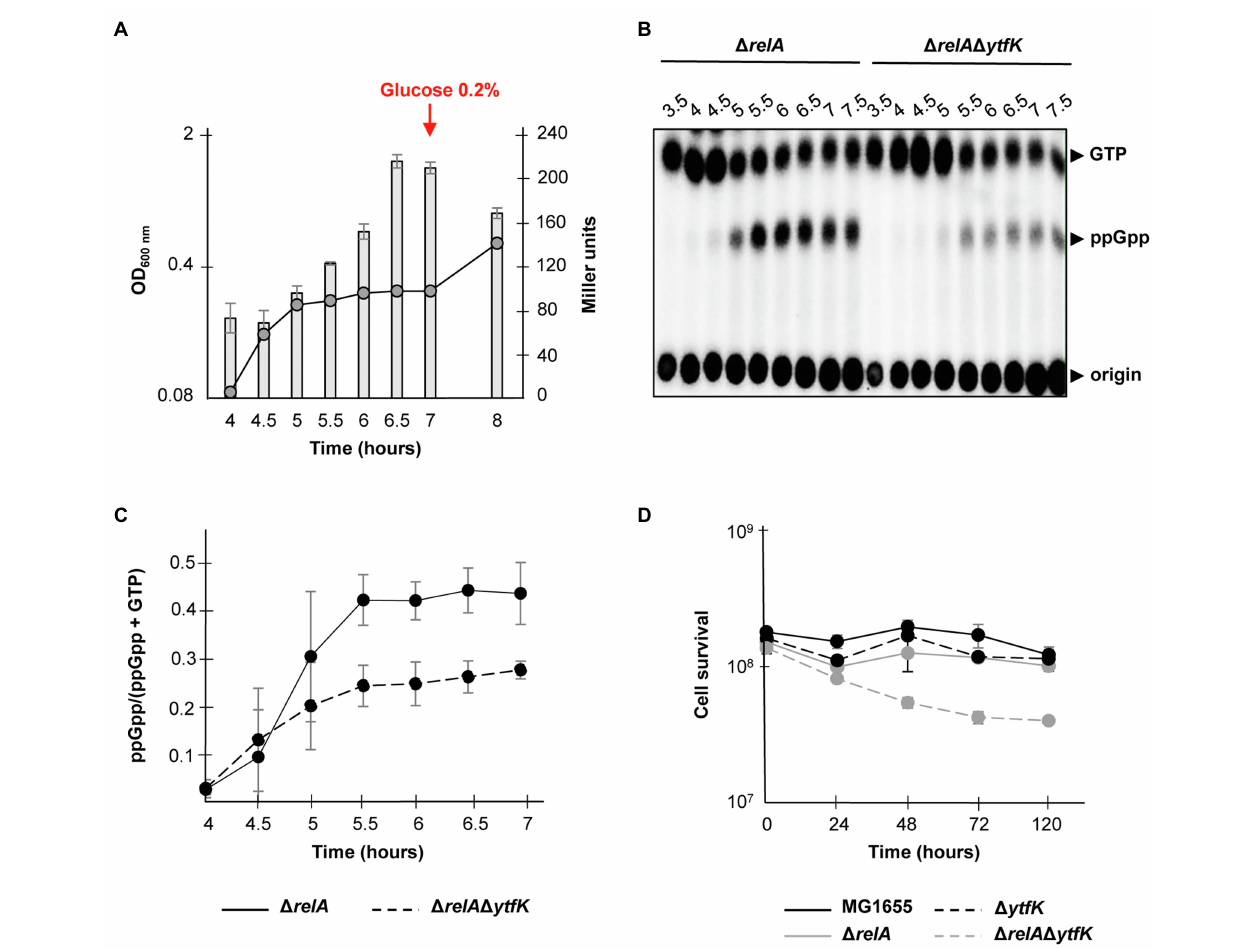
FIGURE 4 | ytfK is required for SpoT-dependent (p)ppGpp accumulation during glucose exhaustion. (A) Growth curve and β -galactosidase activity assay of WT cells in glucose limited minimal medium. WT (TB28) cells harboring the transcriptional fusion ( ytfK P1+ P2) were grown in MOPS minimum medium containing 0.025% glucose. The OD 600nm values of the cultures (curve) were taken and β -galactosidase activity (bar chart) was measured at indicated times. After 7 h of growth, glucose was added at a final concentration of 0.2%. Error bars indicate the standard deviations of averages of three independent experiments. (B) In vivo (p)ppGpp accumulation in response to glucose exhaustion. The Δ relA and Δ relA Δ ytfK mutants were labeled with 32 P and grown at 37 ° C in low-phosphate MOPS medium containing 0.025% of glucose (see Materials and Methods). Samples were taken at indicated times prior to nucleotides extraction and are separated by TLC. Representative autoradiograph of the TLC plates is shown and quantification is provided in (C) . Error bars indicate the standard deviations of averages of four independent experiments. (D) YtfK is required for long-term survival during carbon starvation in absence of relA. Cells of MG1655 (WT; black line) and isogenic deletion strains Δ relA (gray line), Δ ytfK (black dotted line) and the Δ relA Δ ytfK double mutant (gray dotted line) were grown in M9 minimum medium containing limited concentration of glucose (0.025%). Cell survival (log scale) was determined at indicated time. Error bars indicate the standard deviations of averages of three independent